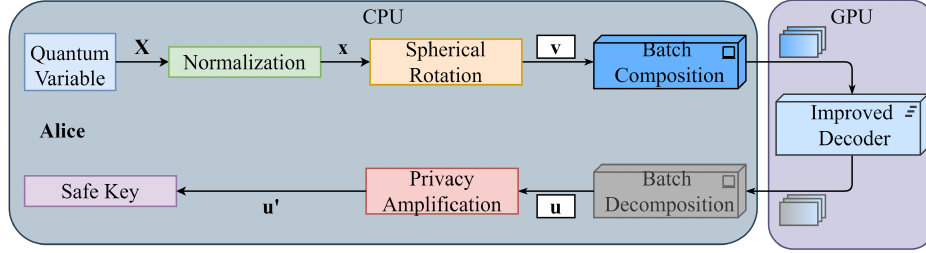
Figure 7. Thearchitectureofthehigh-speedreconciliationschemebasedontheCPU-GPUhybridplatform.